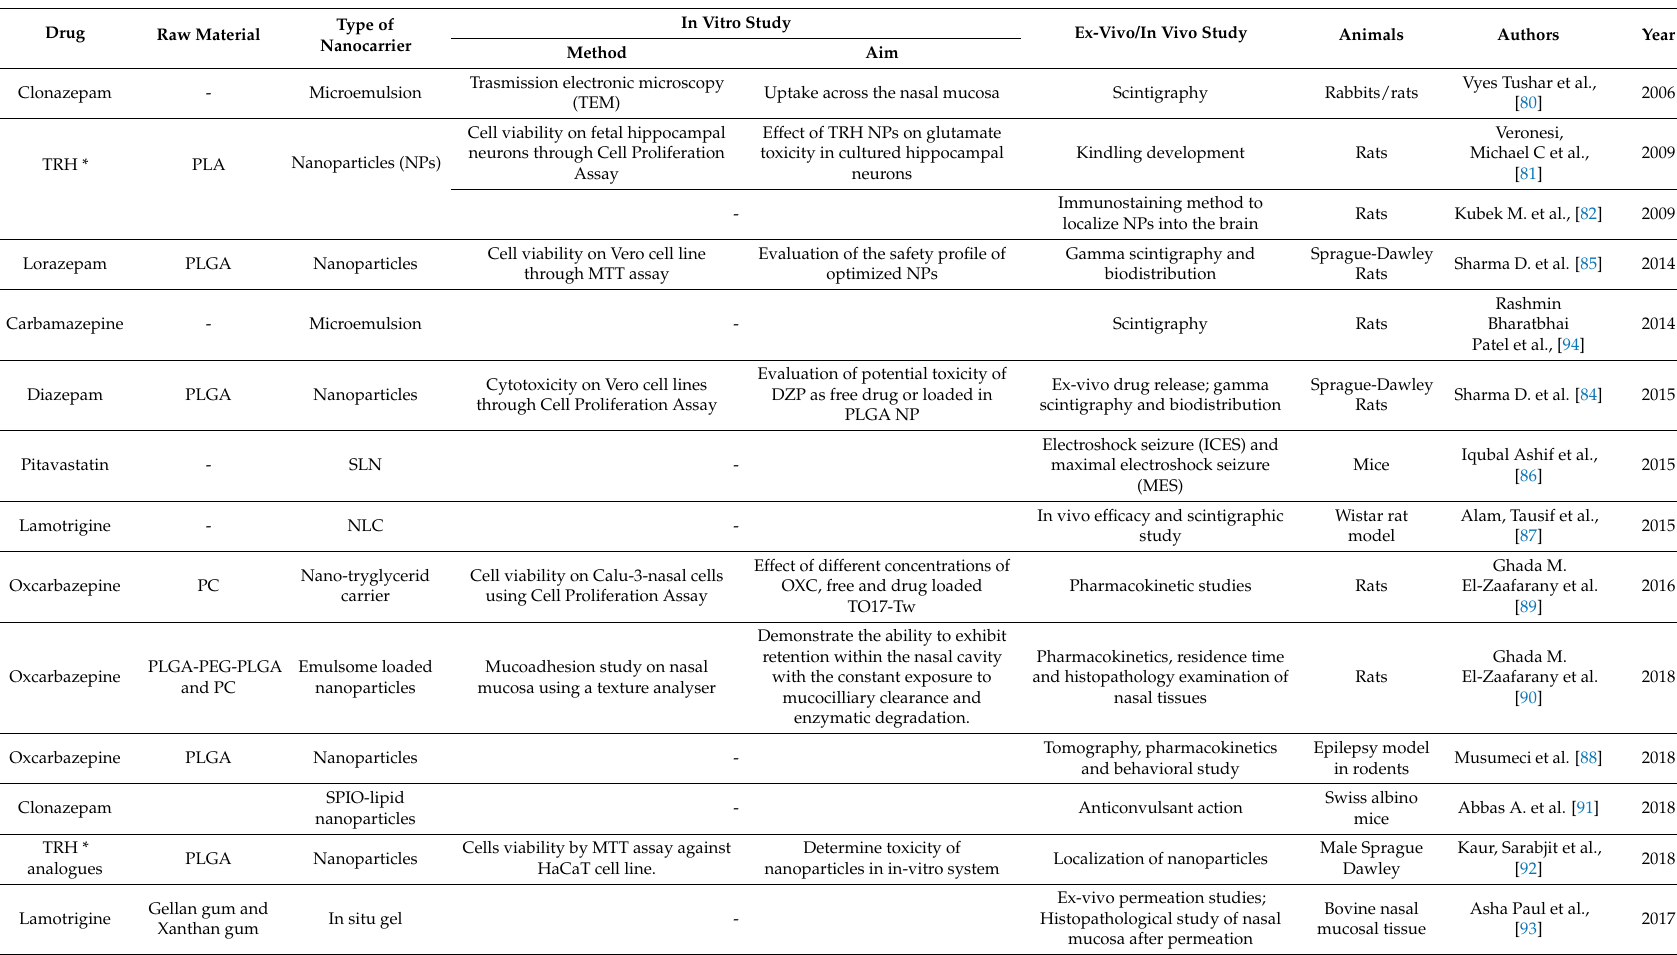
Table 2. Nanosystem approaches applied to the delivery of antiepileptic drugs (AEDs) through the nose to reach the brain with particular attention to in vitro and in vivo